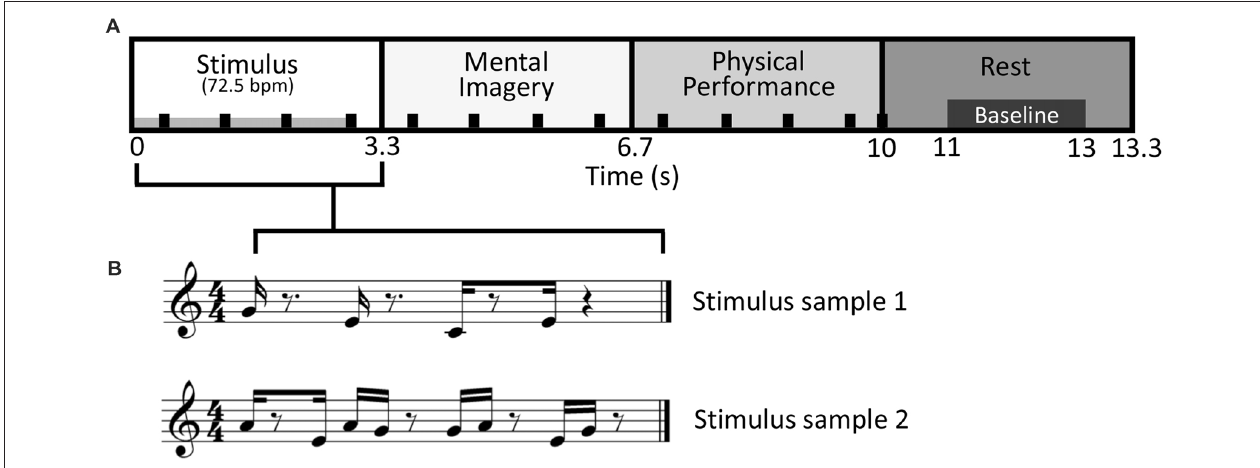
FIGURE 1 | Stimulus-response design. (A) Diagram of the stimulus-response epoch, a variation on “trading fours”. Sixteen different stimulus patterns were used. The duration of stimulus presentation is indicated by the gray bar in the lower left of the stimulus period. Responses during the Mental Imagery and Physical Performance periods were respectively done via mental imagery and on the magnetoencephalography (MEG) compatible keyboard. The black tick marks denote the backbeat that was present during the first three periods, ending on the first beat of the rest period. (B) Two sample stimuli patterns shown in the time frame of the Stimulus period, in musical notation for representative purposes